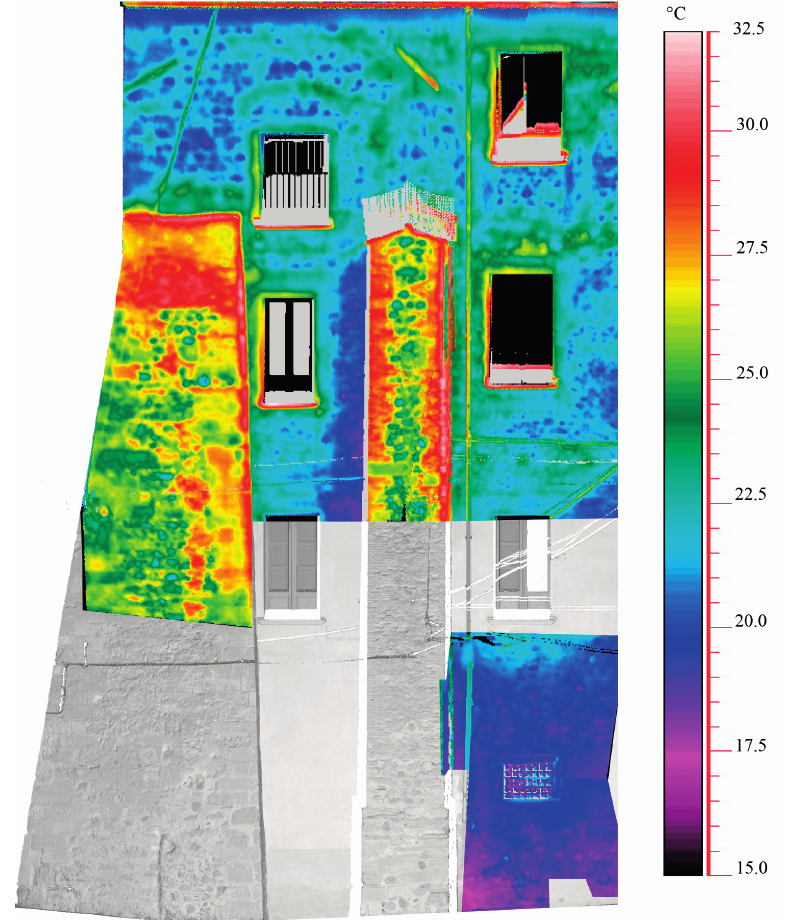
Figure 8. Thermograms projected on the point cloud relating to the external wall (represented up to Section II with reference to the Figure 7) of the St. Augustine Monumental